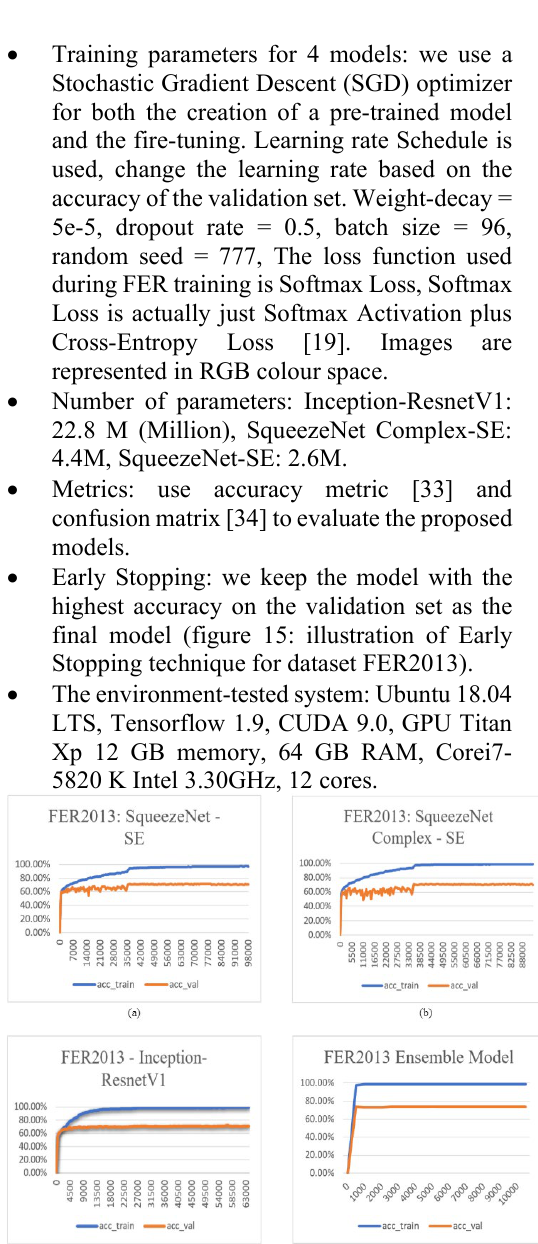
Figure 15. Accuracy on Training Set and Validation Set (acc_train: accuracy training set, acc_val: accuracy validation set).